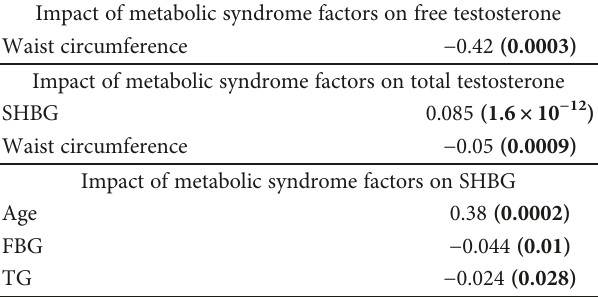
Table 3: Impact of metabolic syndrome factors on free and total testosterone and SHBG by stepwise linear regression.